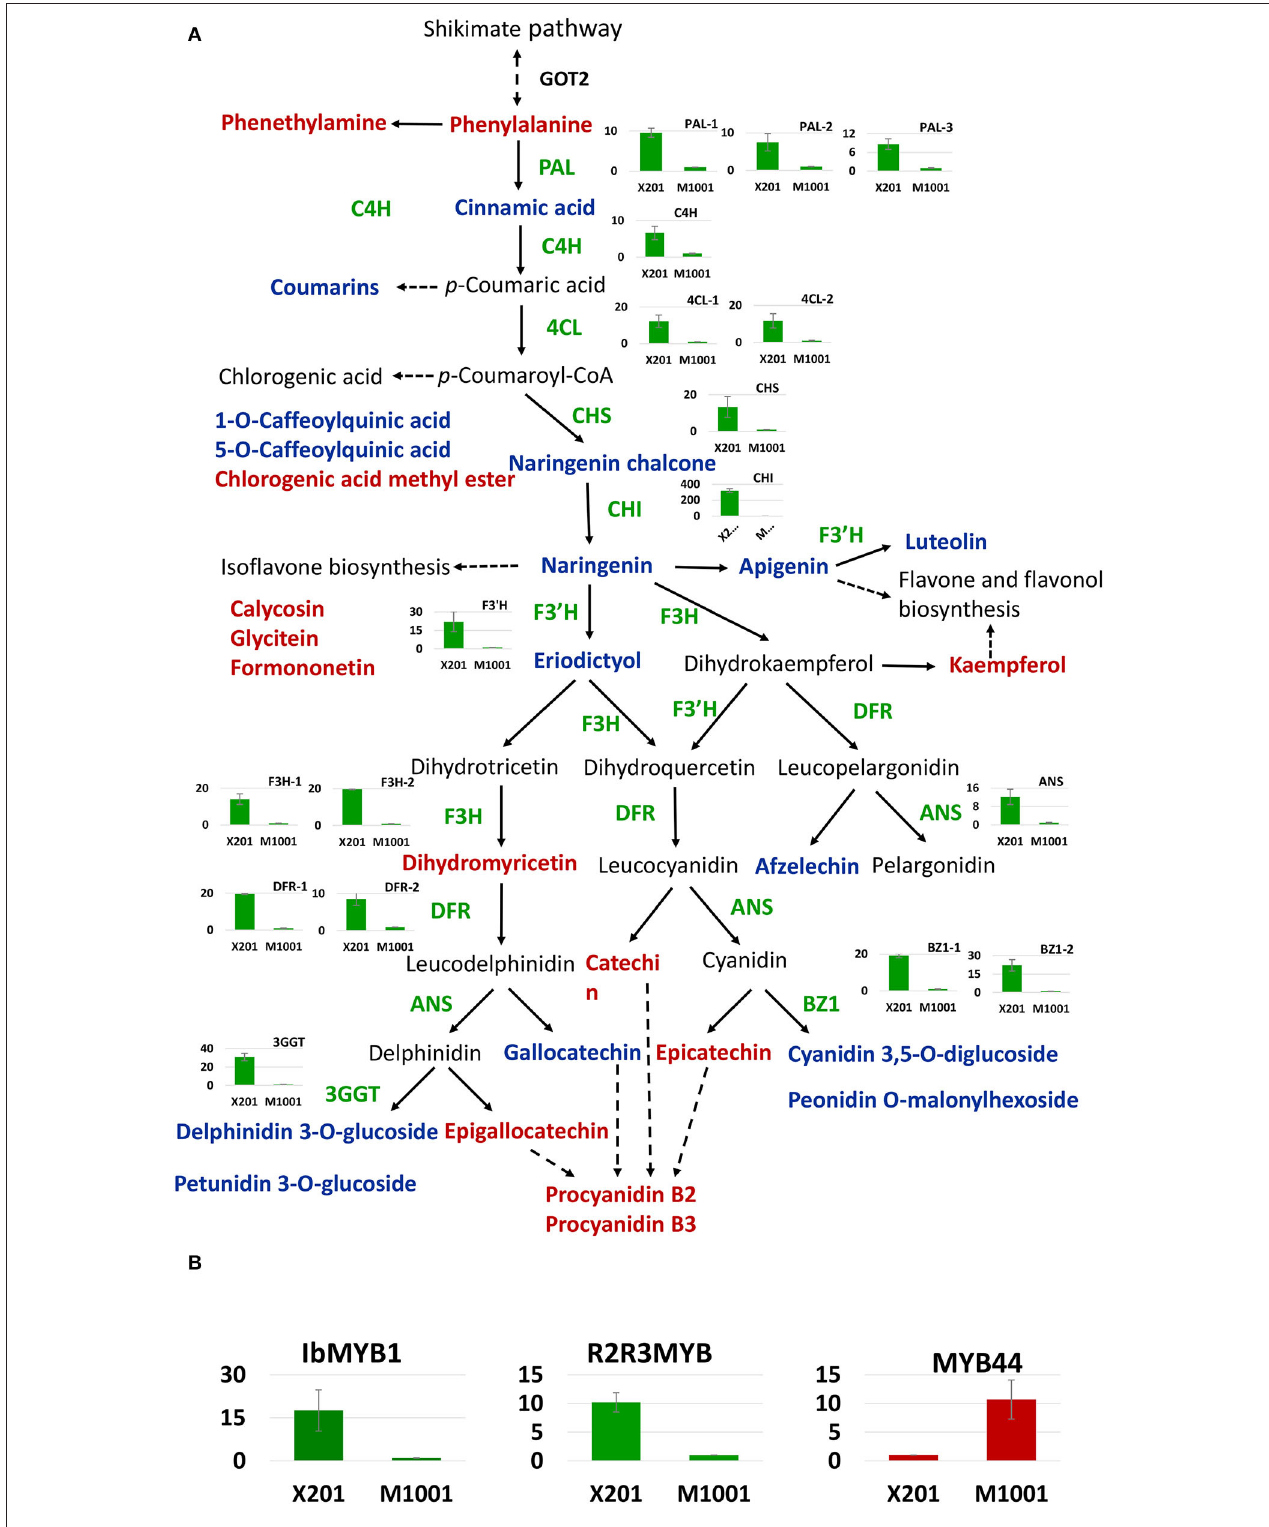
FIGURE 6 | Proposed anthocyanin biosynthesis pathway in sweet potato. X201 and M1001 presented Xuzi201 and M1001, respectively. (A) Transformation of differentially accumulated metabolites (DAMs) and differentially expressed genes (DEGs) in phenylpropanoid metabolism pathway and flavonoid biosynthesis in